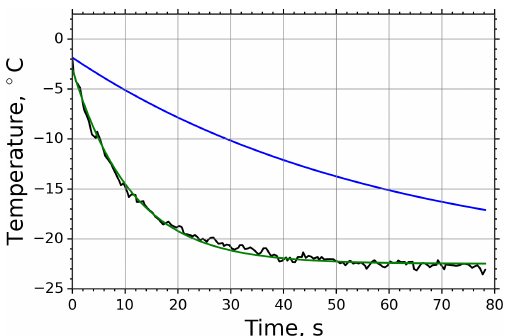
Figure B1. Temporal evolution of the surface temperature of a 2mm diameter drop injected into the M-AL: measured (black line), calculated using Eq. (B16) without ventilation (blue line), calcu- lated using Eq. (B16) with a ventilation factor f v = 5 . 2 (green